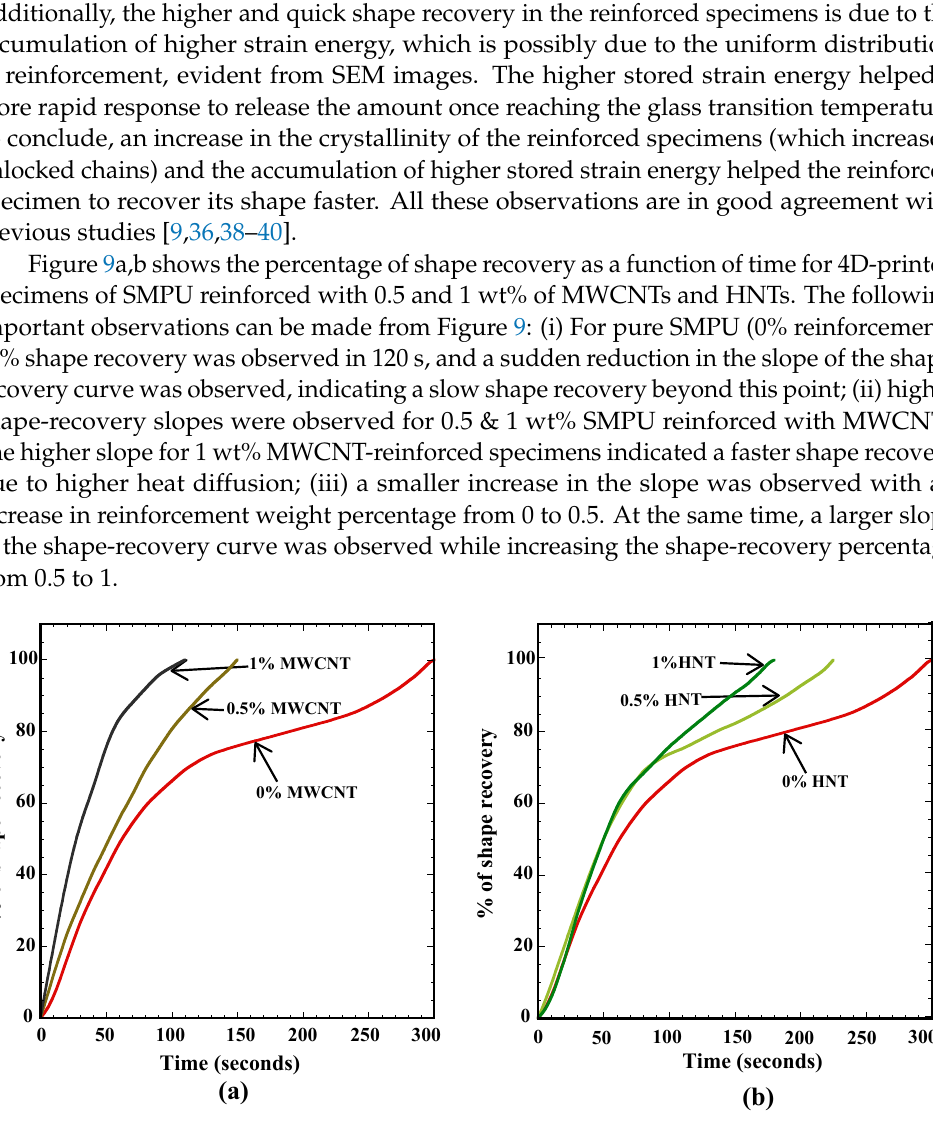
Figure 9. Percentage of shape recovery as a function of time (in seconds) for ( a ) MWCNTs and ( b ) HNTs reinforced 4D-printed SMPU